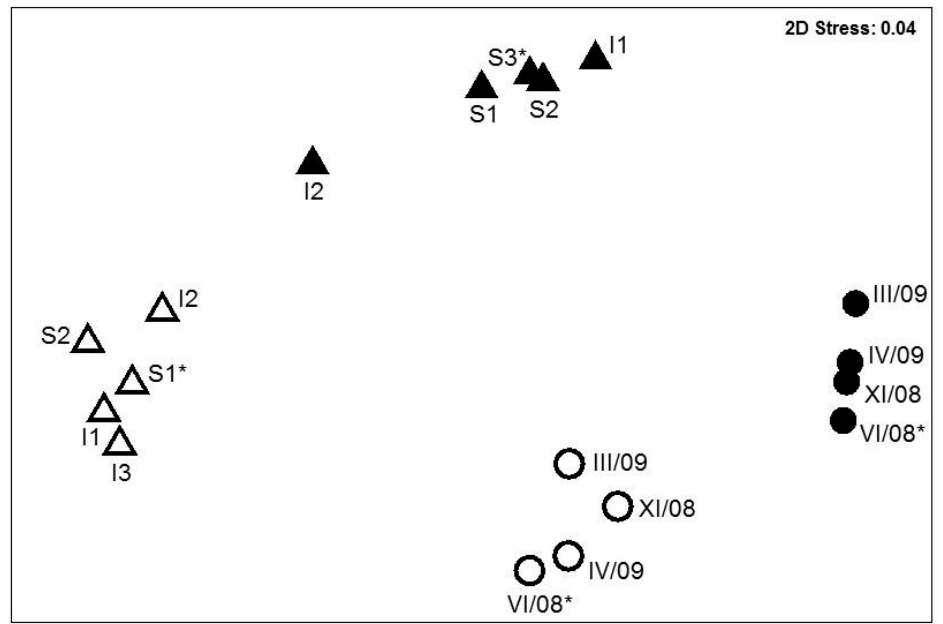
Figure 1. Multidimensional Scaling of bacterial communities from PW water (black circles), UW water (white circles), PW ETBE-enrichment cultures (black triangles) and UW ETBE-enrichment cultures (white triangles). Water samples are labeled with month / year of sampling. ETBE-enrichment samples are labeled I1-I3 for the initial cultures and S1–S3 the subcultures (see Figure S1 for more details). Samples that were used for 16S rRNA and ethB gene sequencing are marked with an asterisk. The distances between samples were based on Bray-Curtis similarity matrix, which was calculated from normalized probe signals. Low 2D stress value ( < 0.1) indicates that the distances between samples in reduced 2-dimensional space correspond well with the actual multivariate distance between the samples.